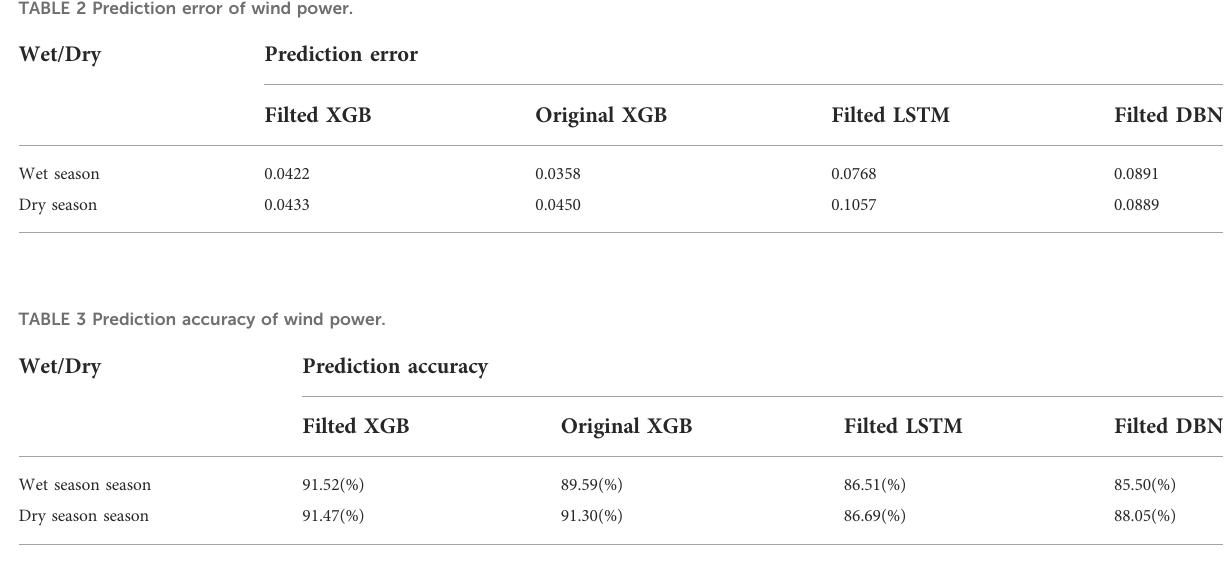
TABLE 2 Prediction error of wind power.